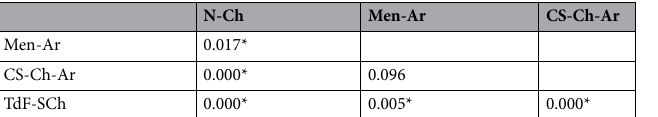
Table 4. Results of the pairwise comparisons between the climatic niche of each mitochondrial phylogroup of Abrothrix olivacea assessed with a Permutational Multivariate Analysis of Variance (PERMANOVA). Significant differences ( p -value ≤ 0.05) between are indicated with an asterisk.